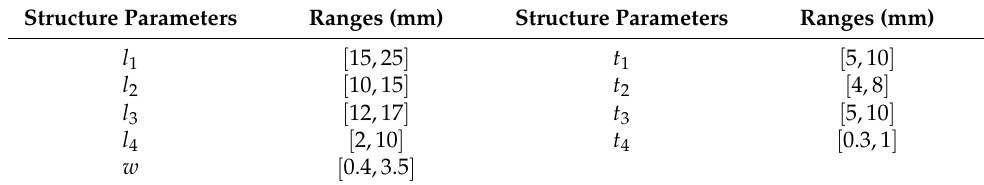
Table 3. The ranges of structure parameters.